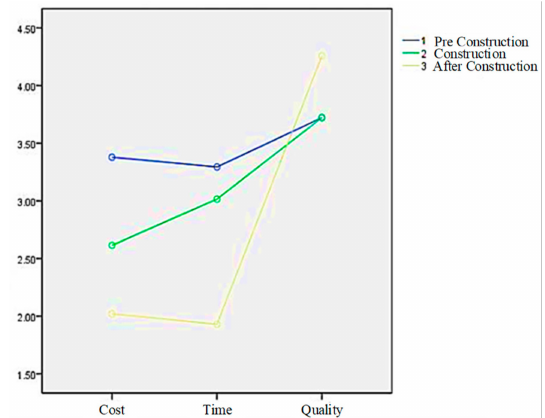
Figure 1. Comparison of trends in indicators (cost, time, quality) in stages (pre-construction, construction,